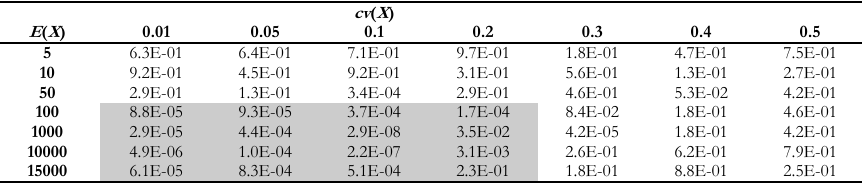
p-values of the S-W normality test computed on the sample means